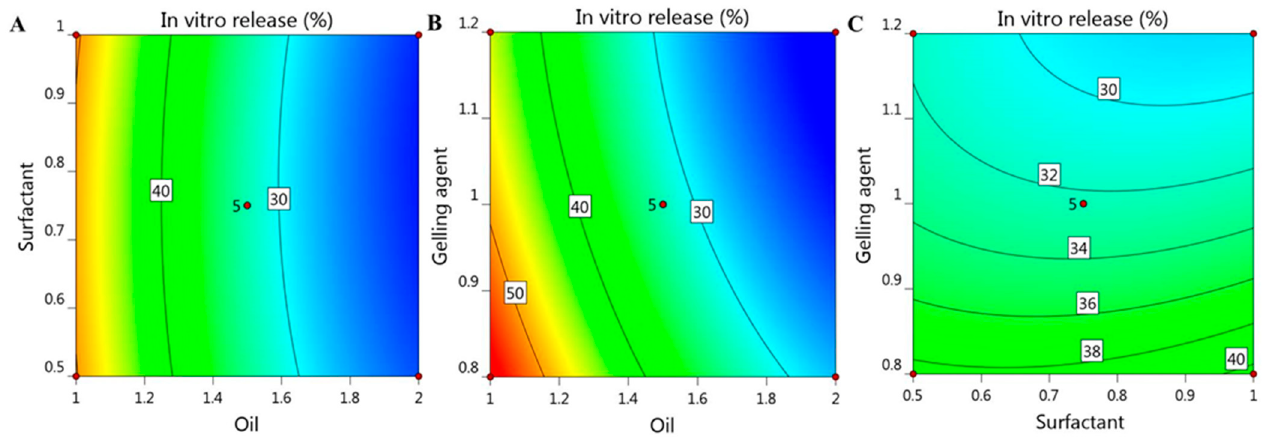
Figure 7. 2D contour graph representing the effect of independent factors ( A ) X 1 and X 2 , ( B ) X 1 and X 3 , and ( C ) X 2 and X 3 on in vitro release response (R 2 ).